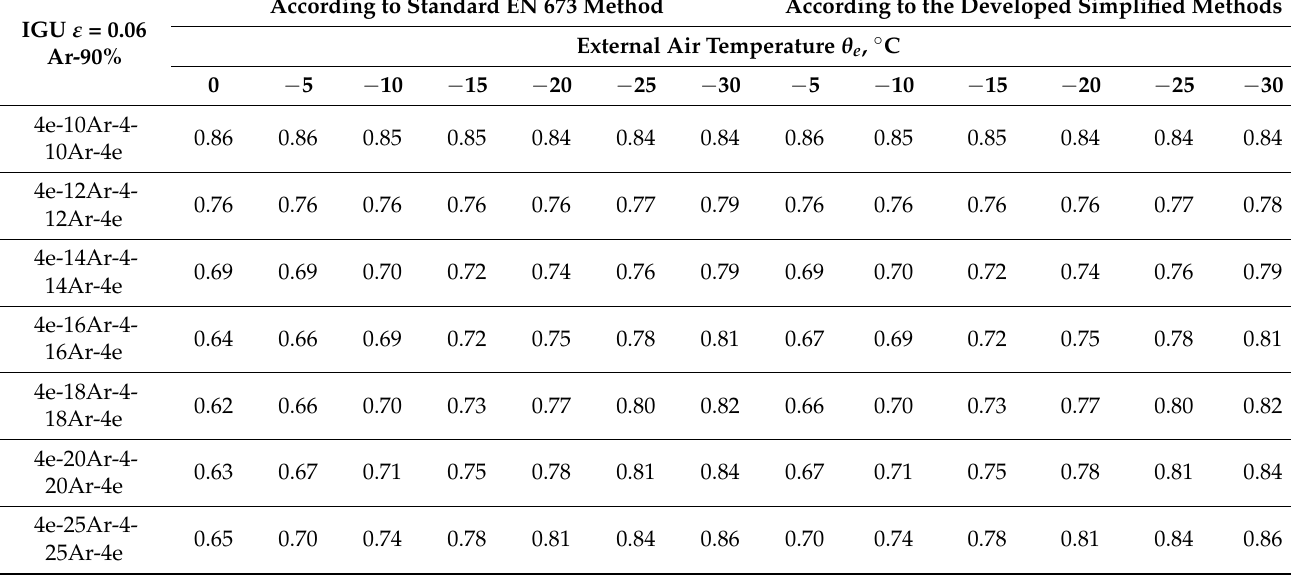
Table 7. Dependence of thermal transmittance of a triple-glazed IGU on the distance between glass panes and the external air temperature using standard methods and developed simplified methods. IGU ε =